Question: Does the figure show an increasing or a decreasing trend?
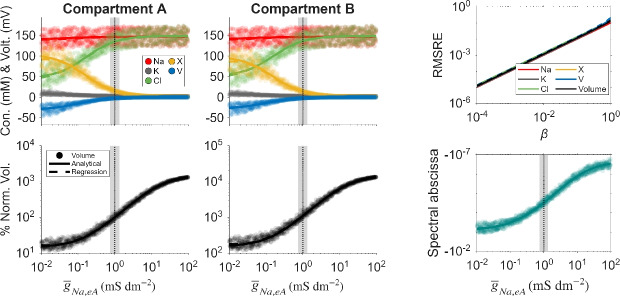
Answer: increasing